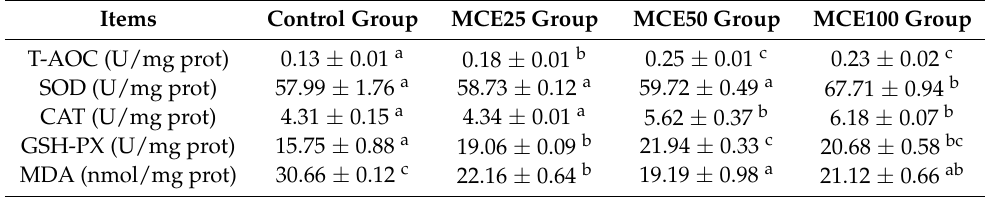
Table 3. Effects of dietary MCE supplementation on intestinal antioxidant parameters of the juvenile American